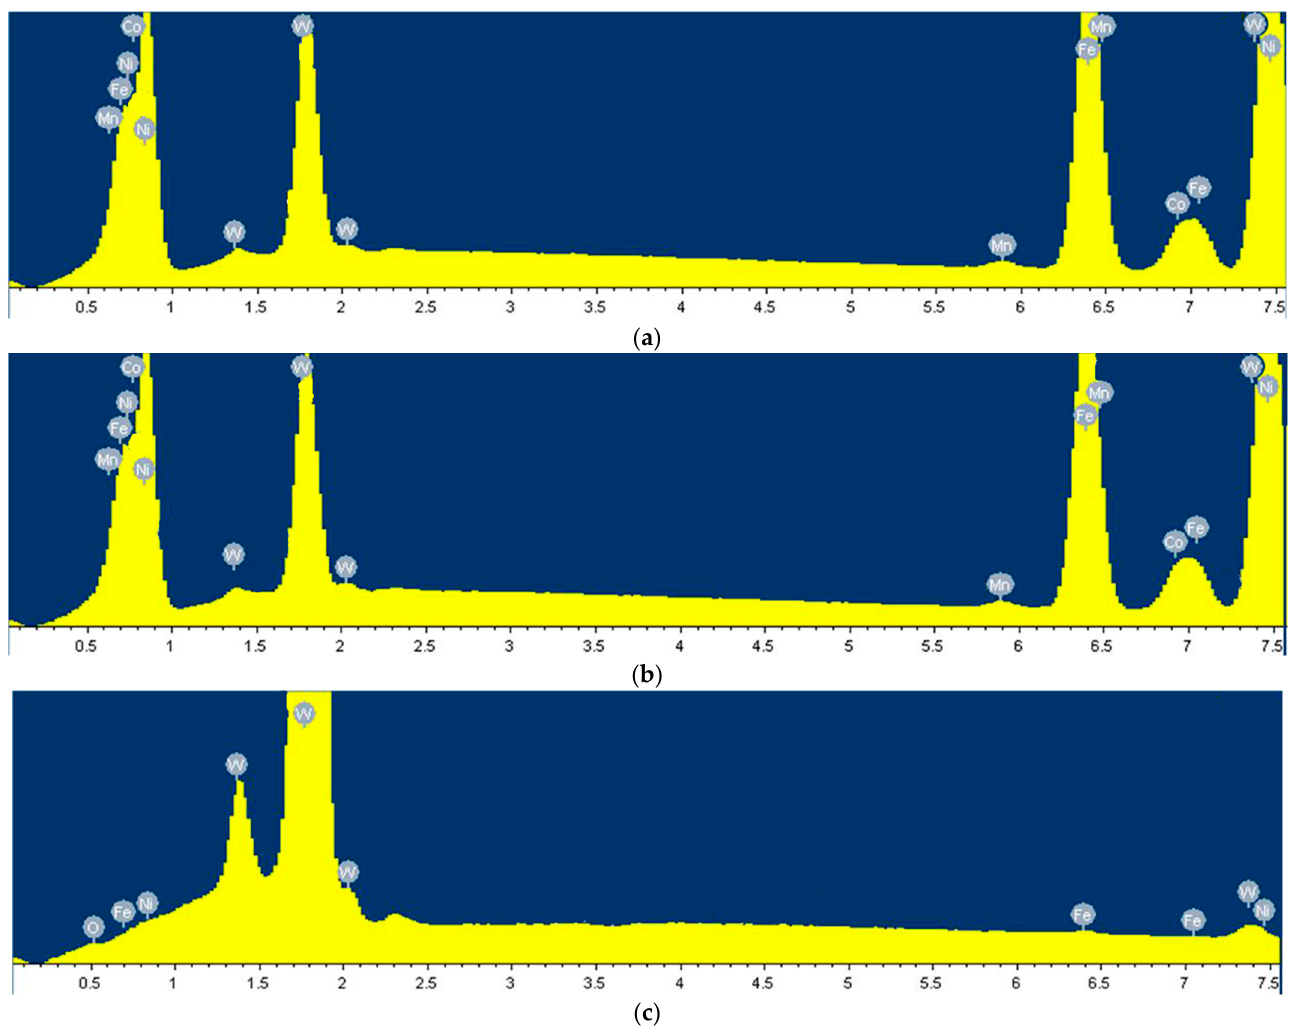
Figure 7. The chemical composition and element distribution of the sintered bar strengthened by HIP. ( a ) The chemical composition of bonding phase at 1200 °C and 140 MPa. ( b ) The chemical composition of bonding phase at 1300 °C and 140 MPa. ( c ) The chemical composition of tungsten particles at 1300 °C and 140 MPa.